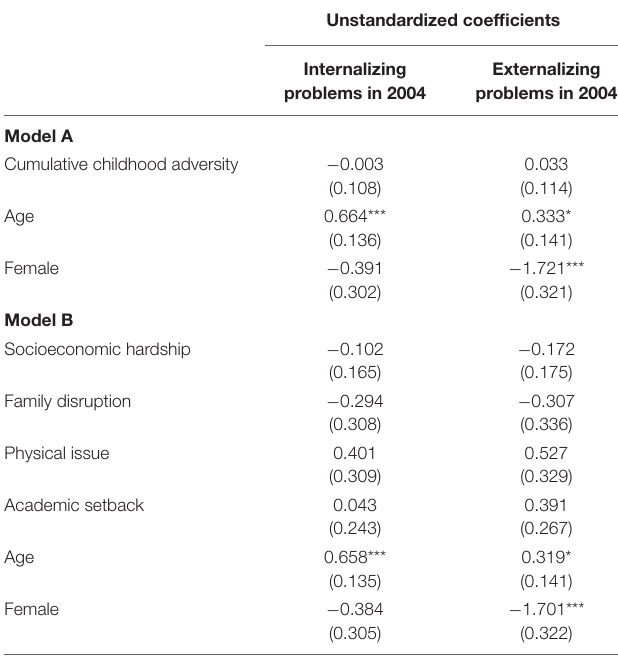
TABLE 3 | Maximum likelihood estimates of the associations between cumulative childhood adversity and mental health in